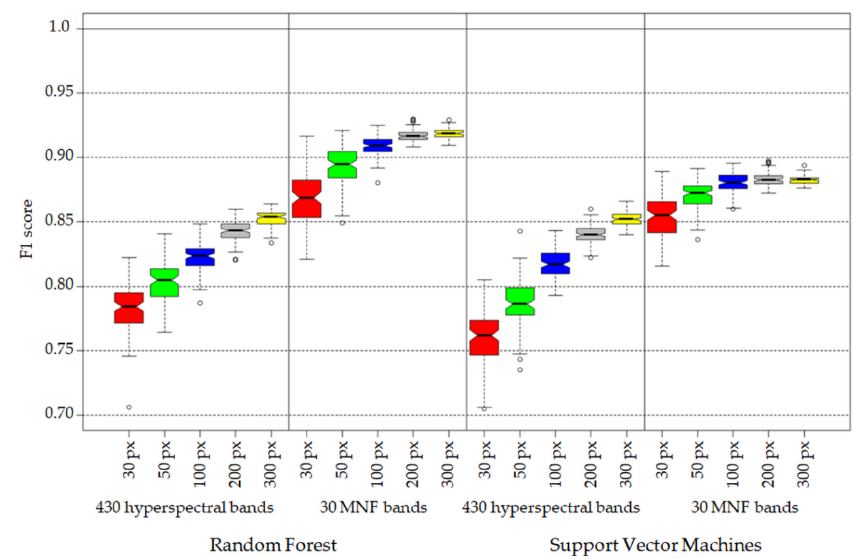
Figure 5. Distributions of mean F1 scores for all classes calculated on the validation data set for SVM and RF classifiers; both analyzed raster data sets and a different number of training pixels. Explanations are presented in Figure 4.